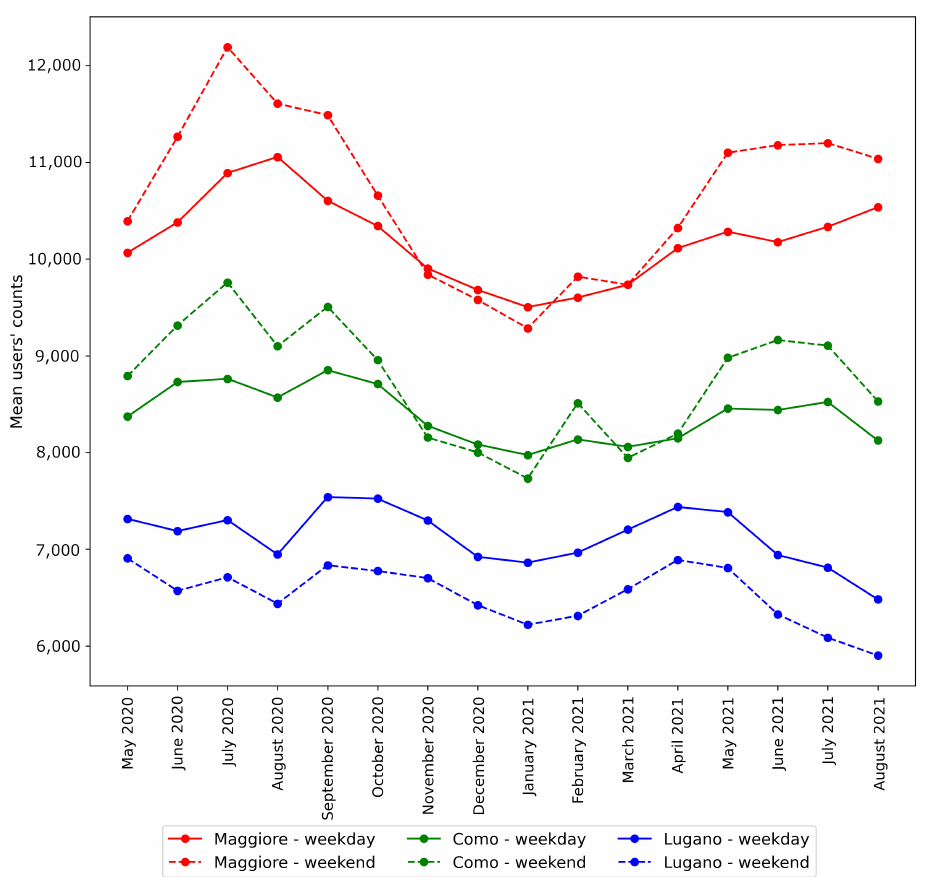
Figure 3. Time series of the monthly mean Facebook users’ count by weekends (dashed line) and weekdays (solid line) for the three